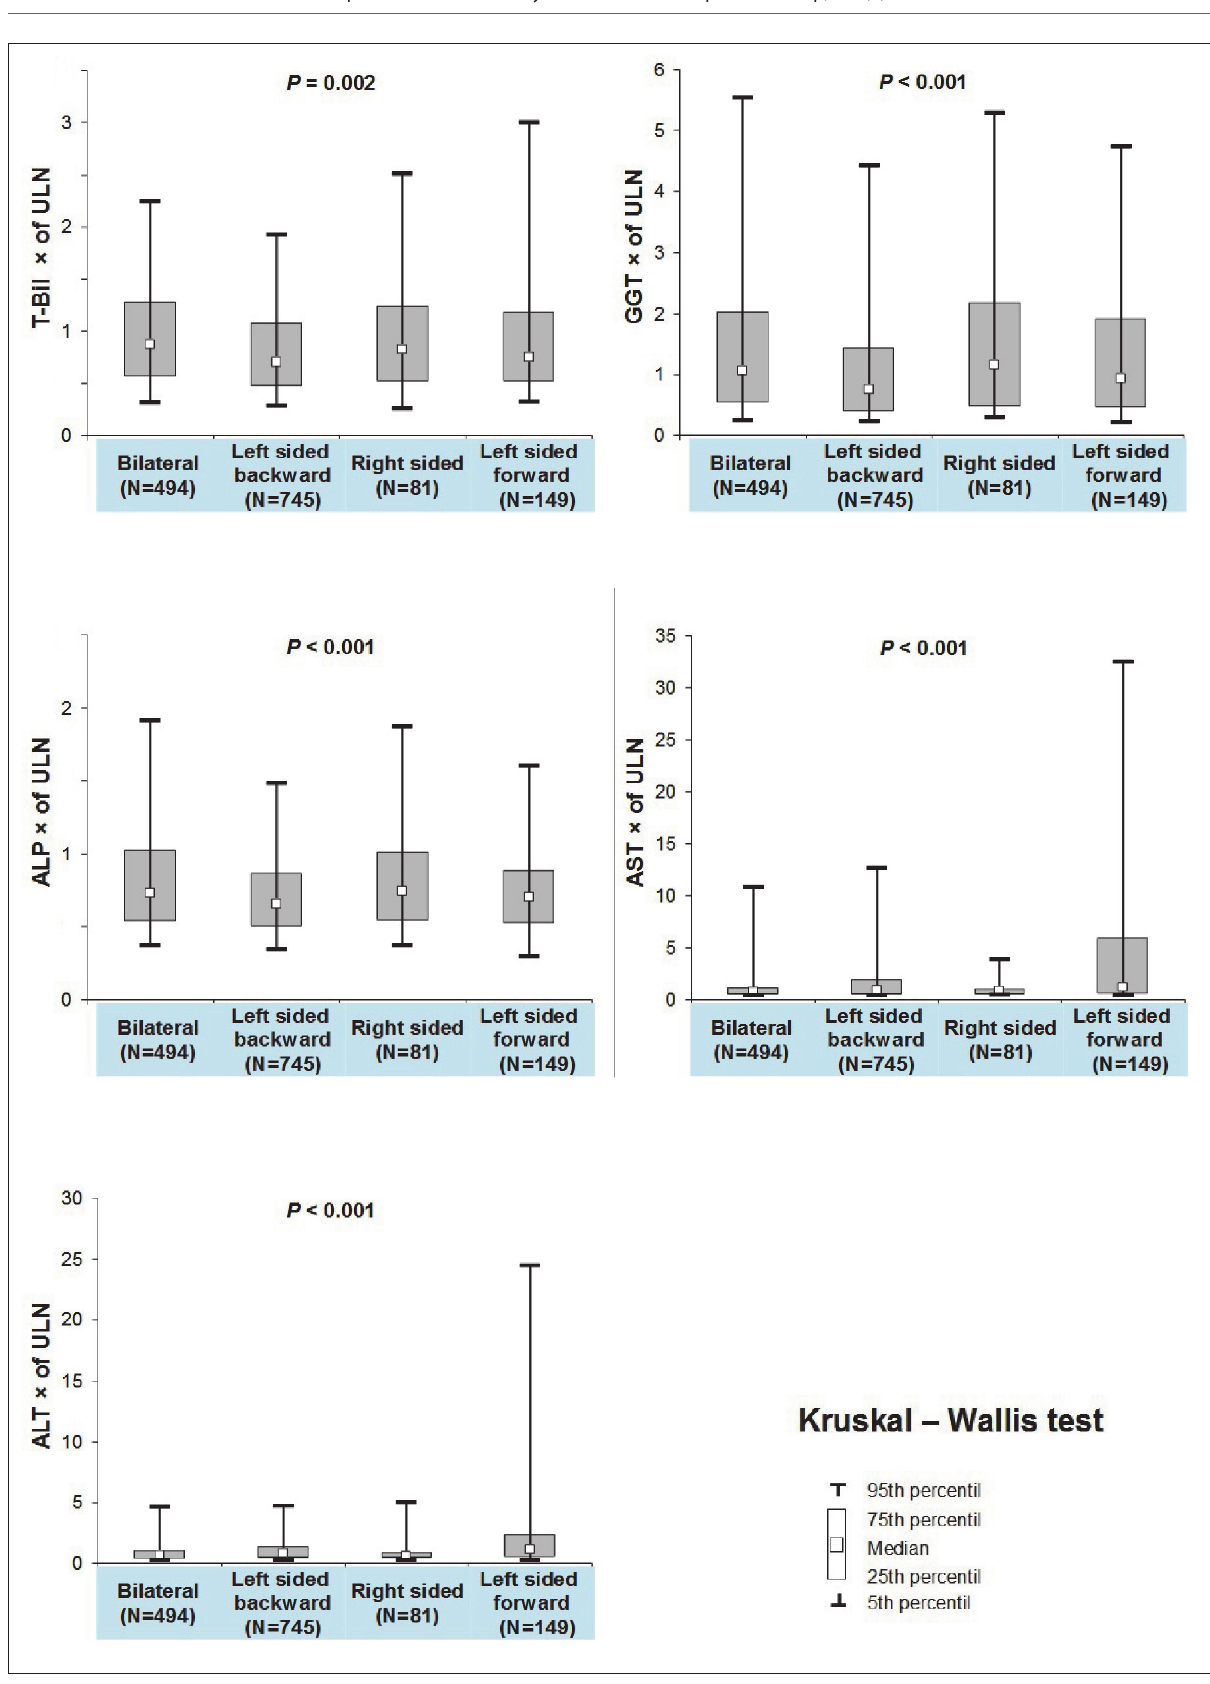
Fig. 2. Distribution of LFTs elevations according to clinical manifestation of